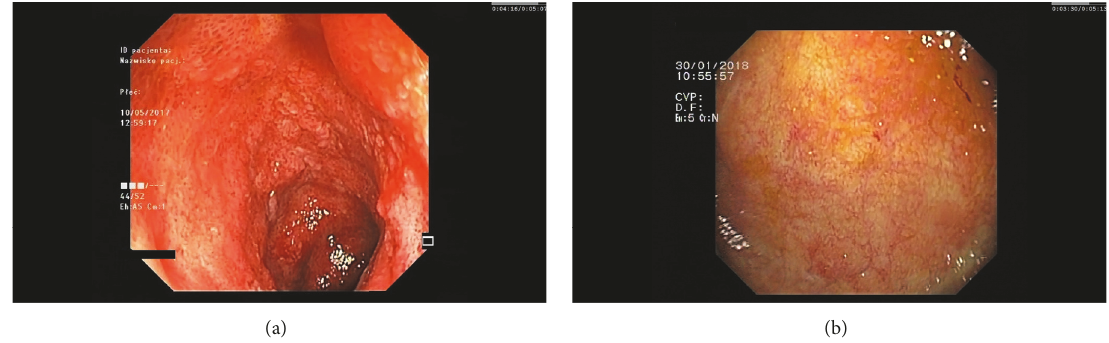
Figure 1: Representative endoscopy images: (a). Initial ileoscopy showing erythematous, edematous friable mucosa with the presence of spontaneous bleeding. (b). Follow-up ileoscopy demonstrating normal looking mucosa after 5 months of vedolizumab